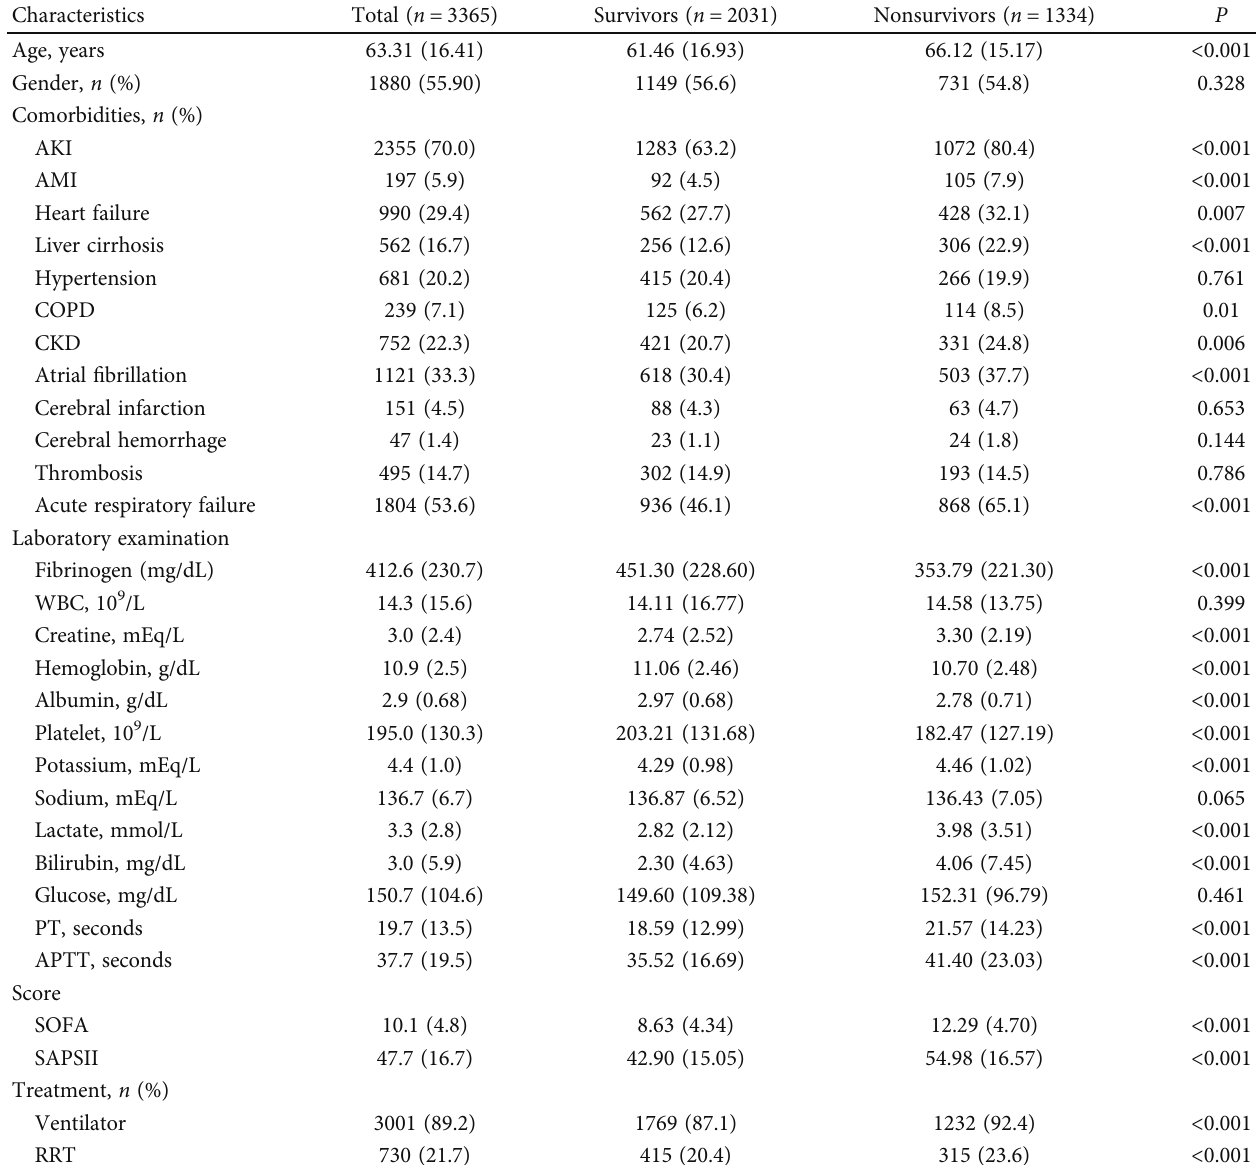
Table 1: Baseline characteristics of enrolled